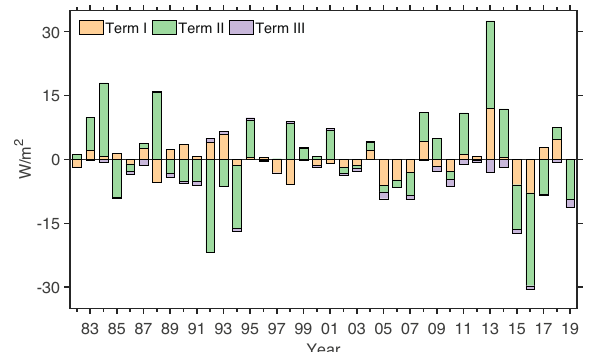
Fig. 5 Decomposed turbulent heat fl ux during the winter of historical period (1982 – 2019). Decomposed turbulent heat fl ux anomalies in winter (October – January) from 1982 to 2019 in the study region. Term I: The turbulent heat fl ux anomalies derived from surface wind speed anomalies (orange), Term II: The turbulent heat fl ux anomalies derived from air-sea temperature/humidity difference anomalies (green), Term III: The turbulent heat fl ux anomalies derived from the nonlinear effects of the air-sea temperature/ humidity difference and surface wind speed anomalies (purple). The positive turbulent heat fl ux anomalies represent the heat trans- ported into the upper